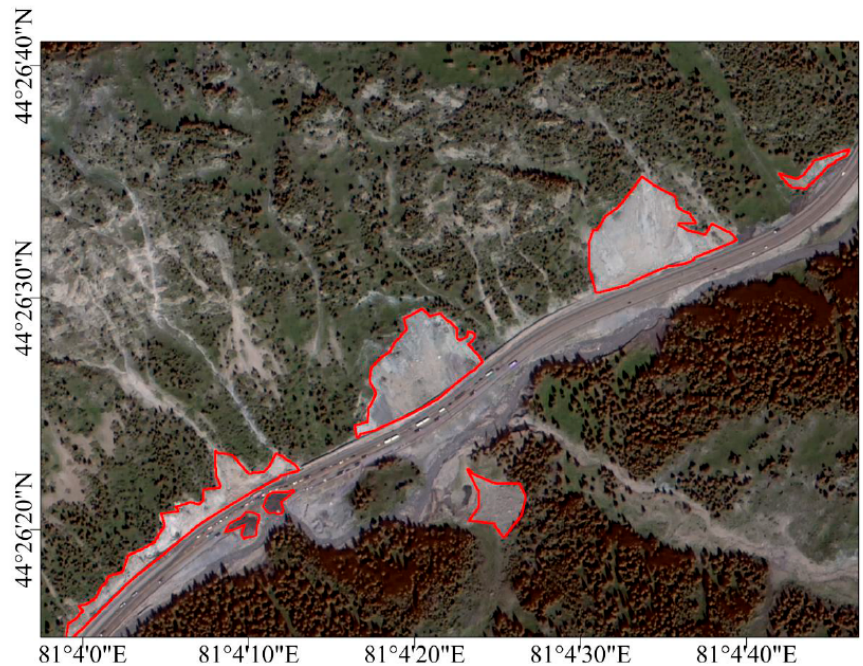
Figure 4. Chinese GF-2 bands 1, 2, and 3 true-color composed images of landslides with red outline which occurred along the highway in the Guozigou Valley on 13 May 2016 after heavy rainfall on 10 May 2016.